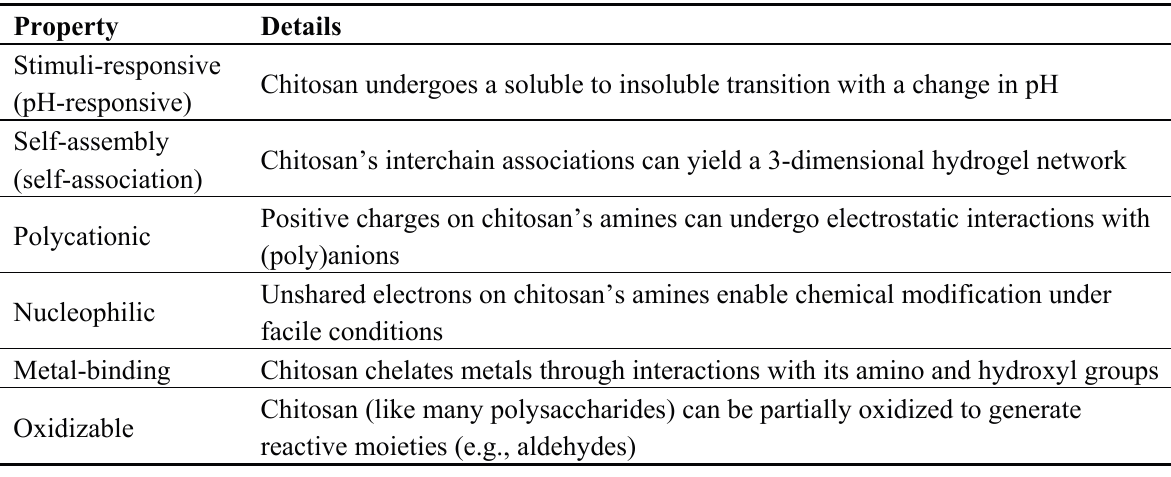
Table 2. Important properties of chitosan for building the bio-device interface and establishing communication across this bio-device